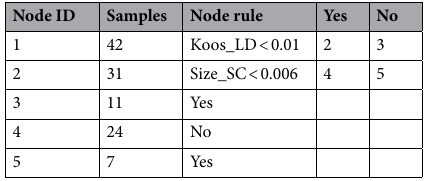
Table 9. Tabular representation of a decision tree for PDA EXP FIN data set.